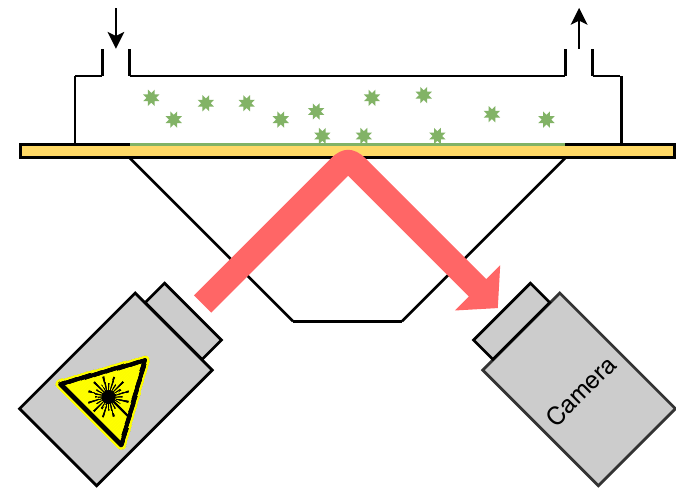
Figure 2. A sketch of the PAMONO biosensor